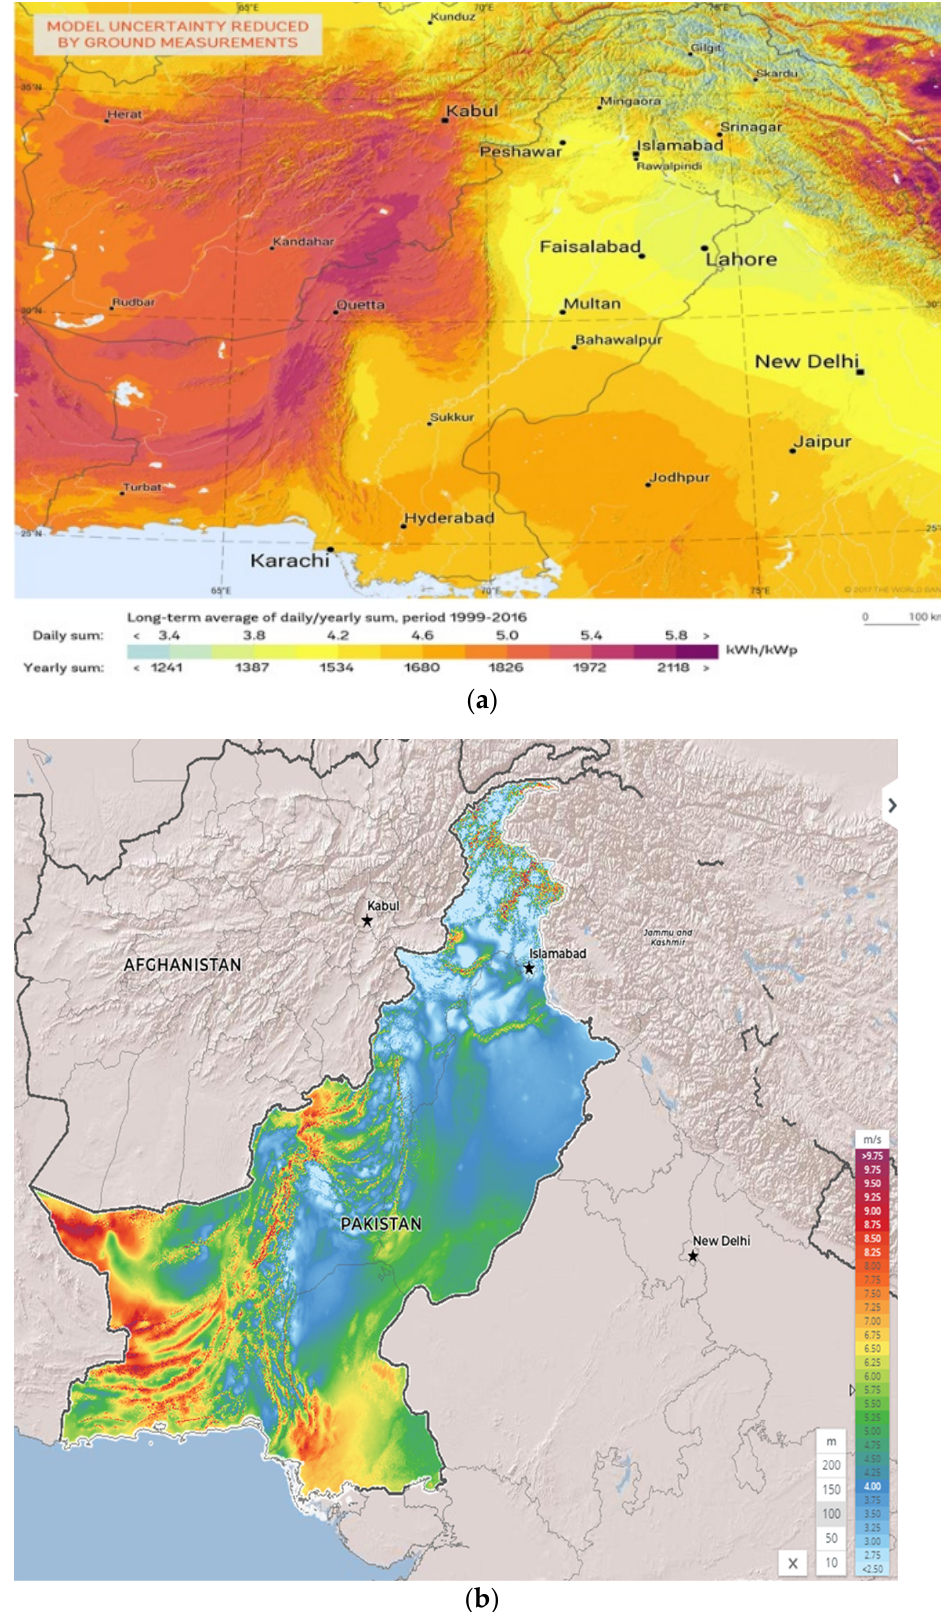
Figure 9. ( a ) Solar potential and ( b ) wind speed map [50,51].